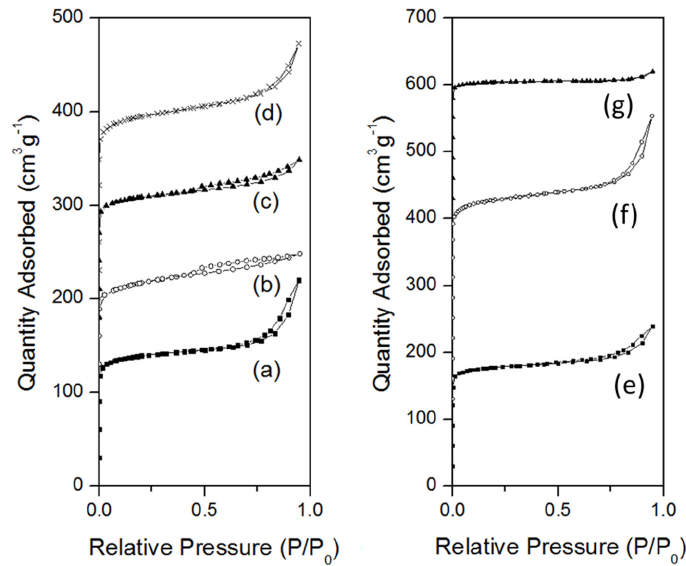
Figure 3. N 2 sorption on (a) Na-SSZ-13-meso-0.2, (b) Na-SSZ-13-meso-0.4, (c) Na-SSZ-13-meso-0.6, (d) Na-SSZ-13-meso-0.8, (e) H-SSZ-13-meso-0.2, (f) H-SSZ-13-meso-0.4, (g) H-SSZ-13-meso-0.6. Isotherms are vertically offset by 100 cm 3 g − 1